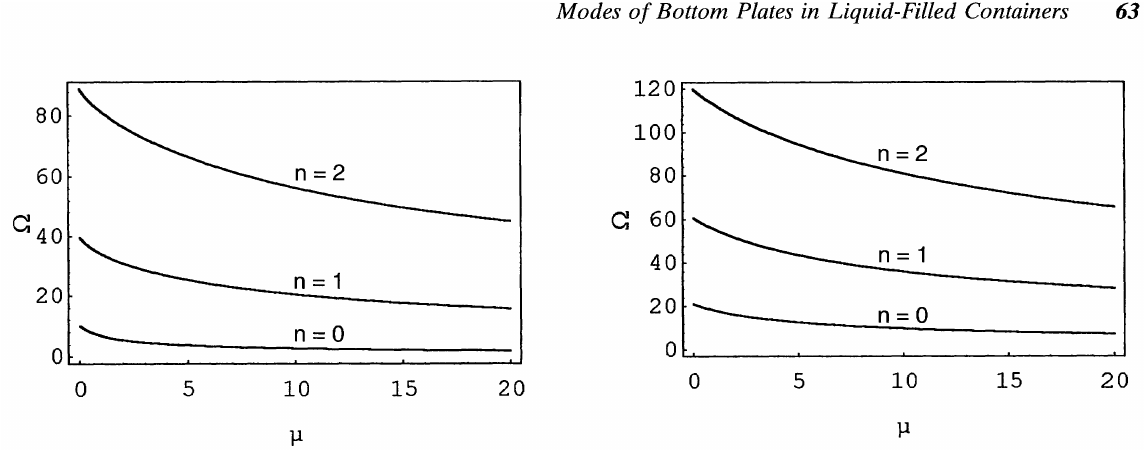
FIGURE 7 The wet frequency parameters n for modes with a nodal diameter (m = 1) of clamped plates having a ratio H/a = 2, as a function of the density thickness correction factor 11-. Curves relative to the first three modes.